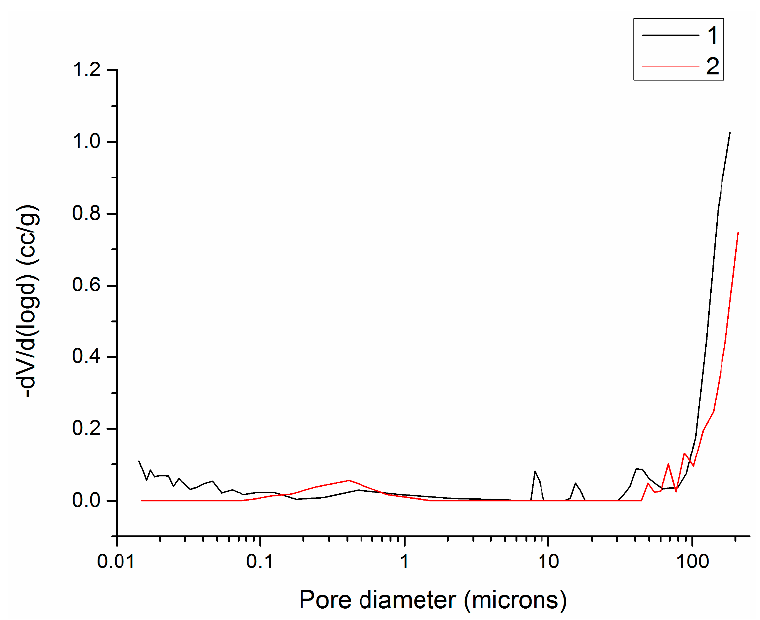
Figure 2. Pore size distribution of coal.